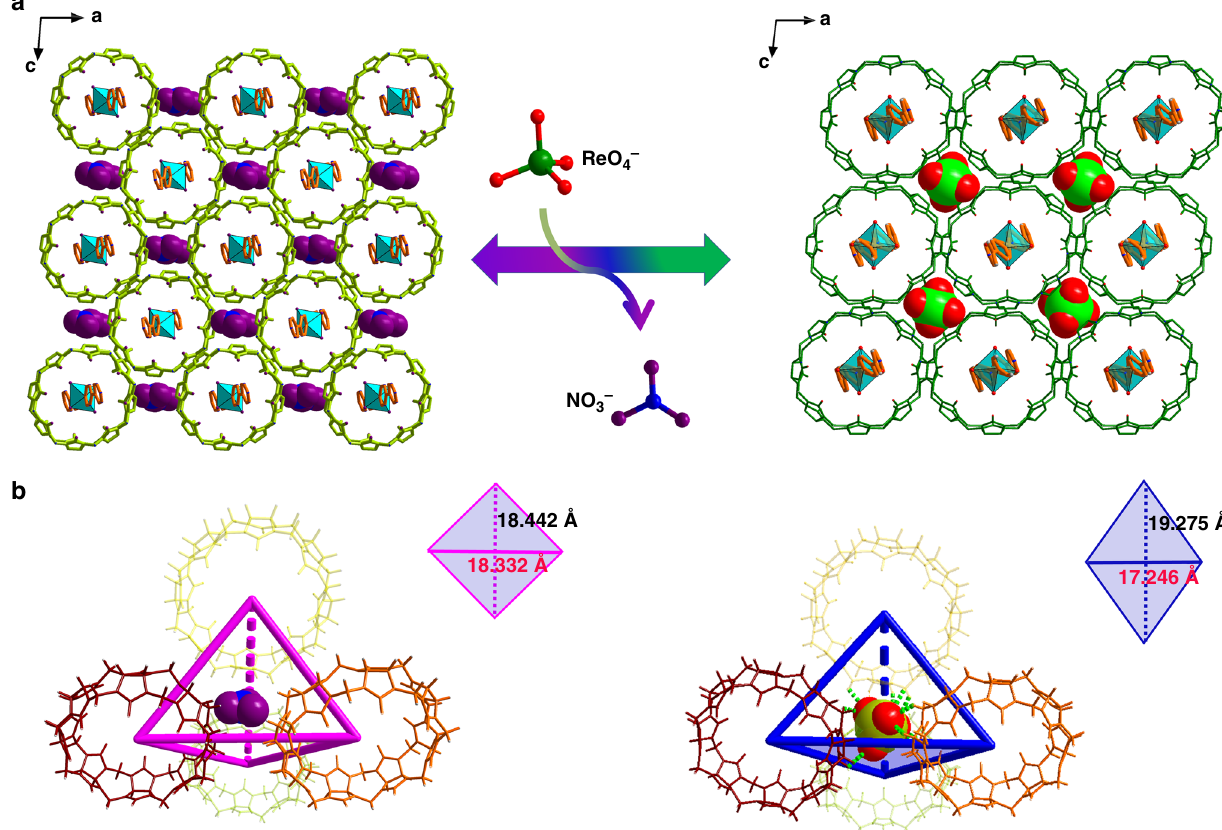
Fig. 7 ReO 4 − exchange-triggered structural transformation of SCP-IHEP-1. a Single-crystal-to-single-crystal (SCSC) transformation from SCP-IHEP-1 to SCP-IHEP-1-Re upon ReO 4 − incorporation. b Adaptive structural transformation of CB8-based tetrahedral cavity after encapsulation of ReO 4 −